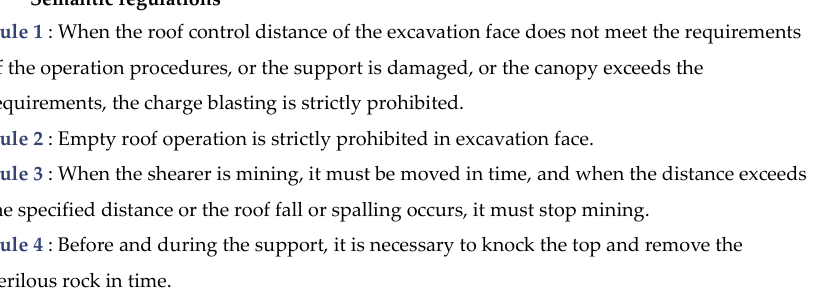
Figure 7. Some safety regulations related to roof fall accidents.